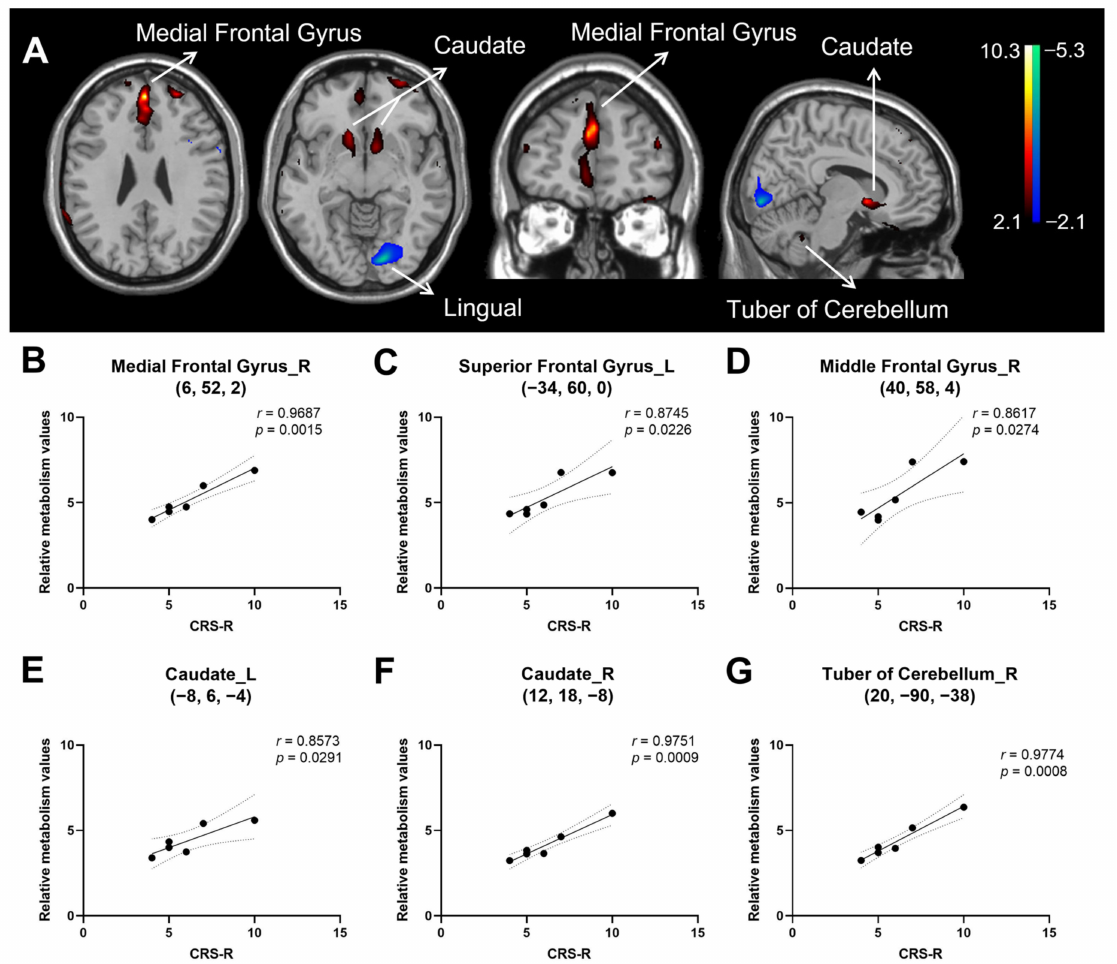
Figure 2. Brain regions correlated with Coma Recovery Scale-Revised (CRS-R) score in hypoxic is- chemic encephalopathy (HIE) patients presenting with disorders of consciousness (DOC). ( A ) Regions with positive correlation (red) were observed bilaterally in the medial frontal gyrus, middle frontal gyrus, anterior cingulate and caudate, and in the left superior frontal gyrus, left inferior frontal gyrus and right tuber of cerebellum, whereas those with negative correlation (blue) were found in the left lingual gyrus. The overlays are depicted in neurologic orientation. The gray-scale image is a T1-weighted structural magnetic resonance imaging (MRI) that is representative of Montreal Neuro- logical Institute (MNI) space. The thresholds of the color bars represent T values. ( B – G ) Correlation between relative metabolic values and CRS-R score the right medial frontal gyrus. Dotted lines represent 95% confidence bands of the best-fit line. ( B ), left superior frontal gyrus ( C ), right middle frontal gyrus ( D ), left caudate ( E ), right caudate ( F ), right tuber cerebellum ( G ). The metabolic values were obtained post hoc within a spherical volume of interest (VOI) (3 mm radius) with the center coordinates of each VOI given in the parentheses on each panel. L, left. R, right. CRS-R, coma recovery scale—revised